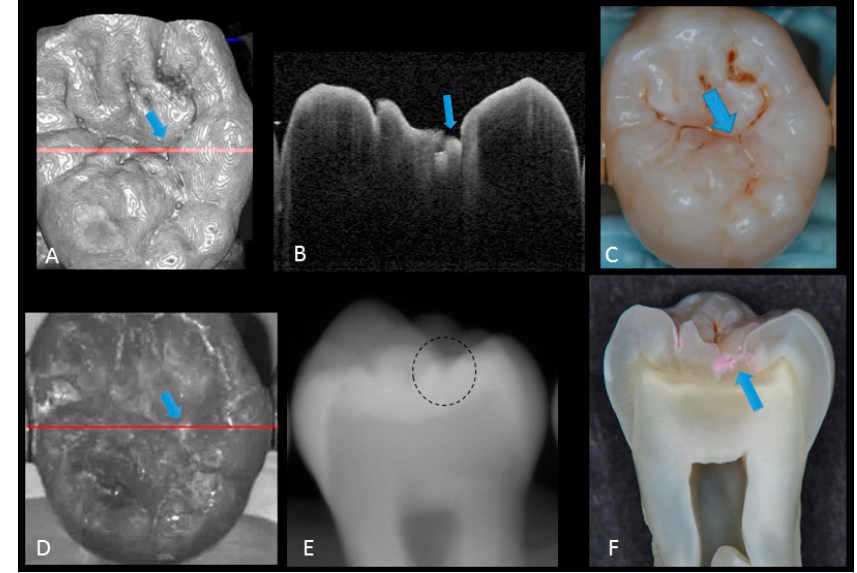
Figure 4. Enamel breakdown: ( A ) gray-scale three-dimensional (3D) OCT image; ( B ) cross-sectional OCT image along the red line in (A) and (D). Arrow shows cavitated caries; ( C ) visual score 2 of enamel cavitation; ( D ) OCT en face intensity projection; ( E ) enamel lesion was not distinguished on radiograph due to the superimposition of buccal and lingual cusps; ( F ) cross-section view with penetration of pink dye enclosed at enamel (score 2). Supplementary Materials: Video 3